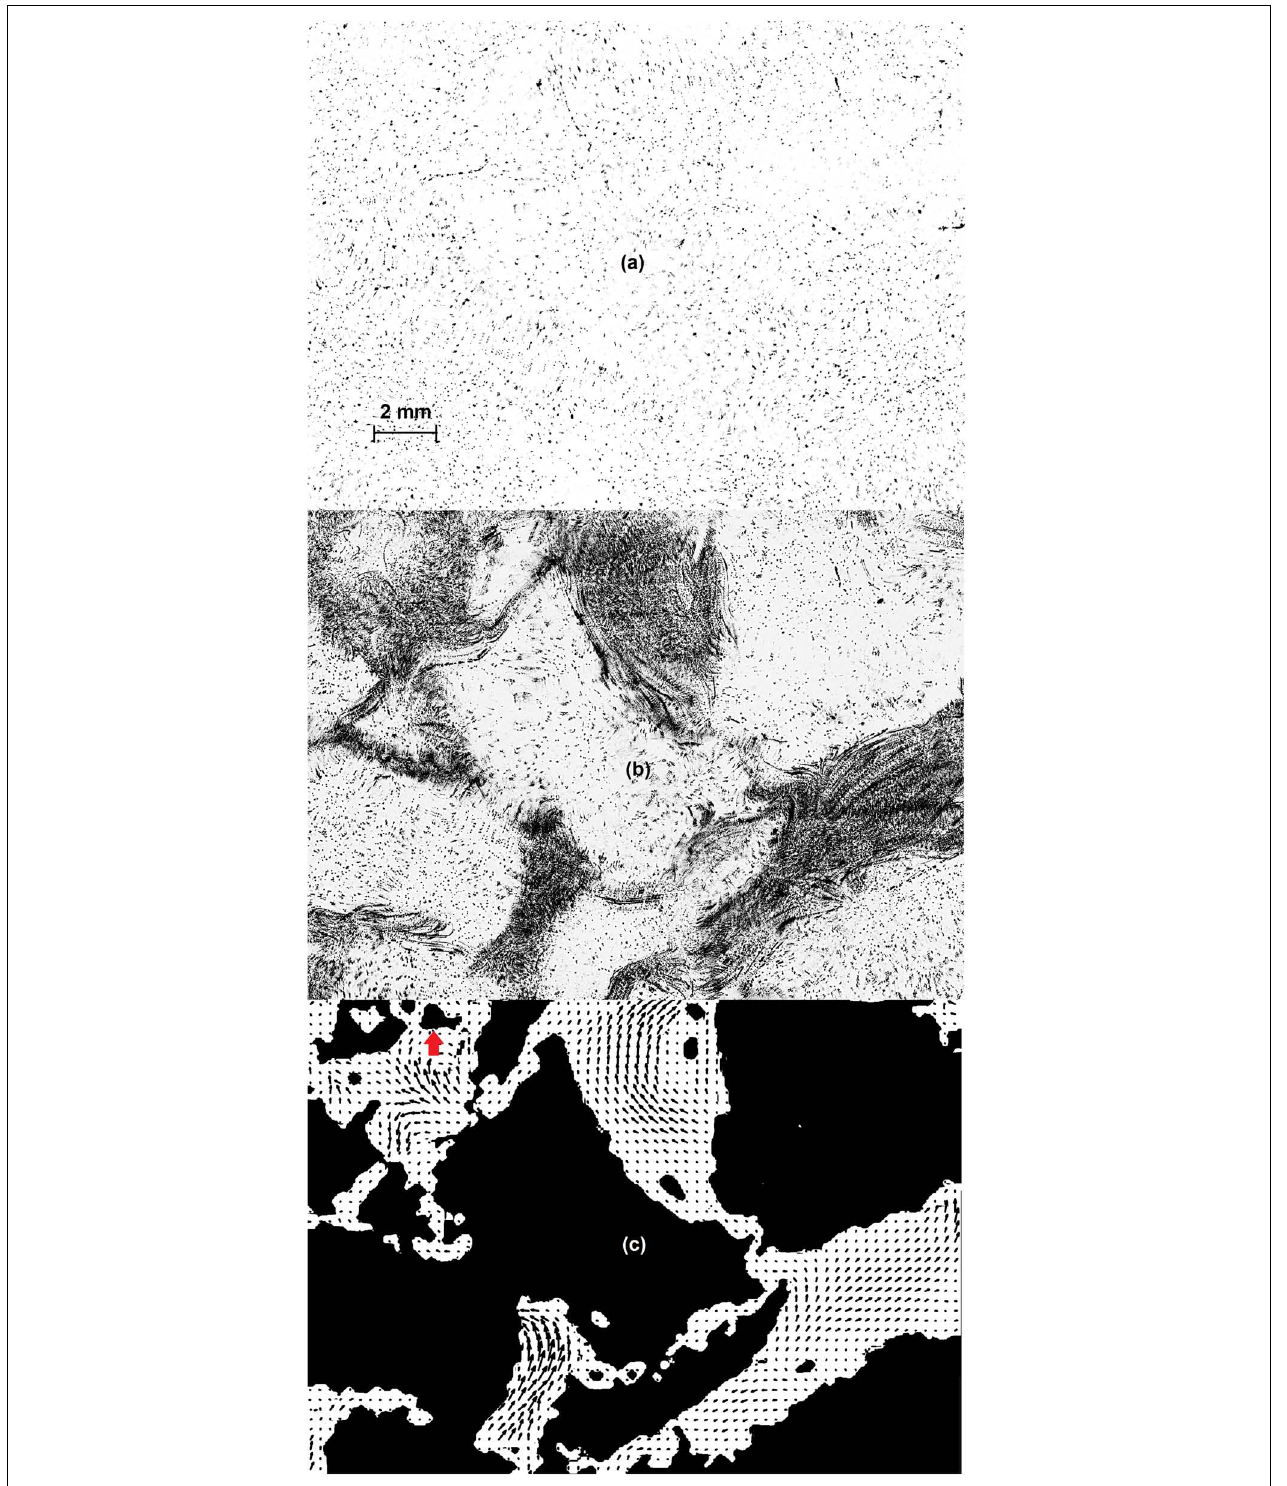
FIGURE 6 | Flow through a packed bed of hydrogel grains. (a) Instantaneous image of particles. (b) Time series of particle motion. (c) Applying near zero-velocity threshold to reveal outline of grains (method 2 for finding the solid-liquid boundary). A velocity vector with length of one grid spacing had a velocity of 1.8 mm/s. The velocity in the interstitial spaces away from the boundary was 2 mm/s. The vector plot shows a vector for every fourth IC. Red arrows shows a solid identified by method (2), which instead should be a slow moving fluid when checked with rms value (method 3).